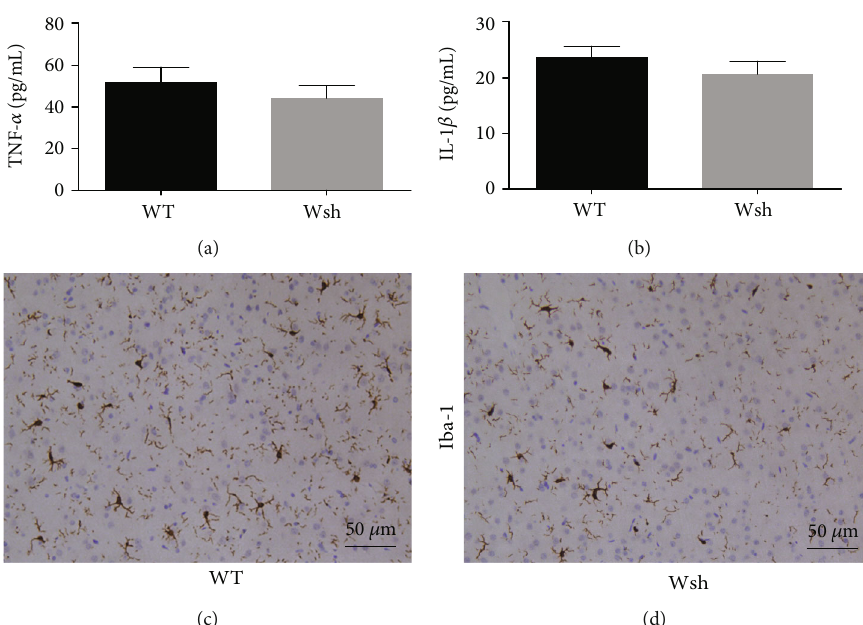
Figure 2: Baseline levels of neuroin fl ammatory markers were una ff ected by mast cell de fi ciency. (a, b) ELISA was used to detect the expression of proin fl ammatory factors TNF- α and IL-1 β . (c, d) Iba1 in area CA1 of the hippocampus was detected by immunostaining. Scale bar is 50 μ m. Data are presented as the mean ± SEM ( n = 5